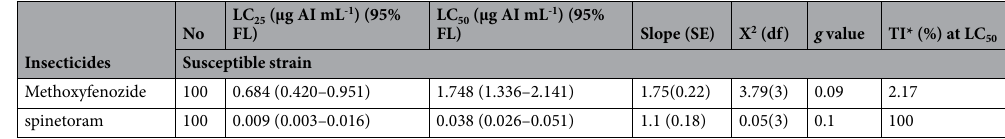
Table 2. Toxicity (LC values) of methoxyfenozide and spinetoram individually to the 2nd instar larvae of a susceptible of Spodoptera littoralis after 96 h. post-treatment. No . number of larvae exposed to the insecticide, LC 25, and LC 50 are concentrations of each insecticide, in μg (microgram) of insecticide per mL (milliliter) of water, that is required to kill 25 or 50% of the tested population, respectively. X 2 chi-square, and df Degree of freedom. g value goodness of fit, and *Toxicity index 39 = LC 50 of the most efficient compound/LC 50 of the other compound × 100.